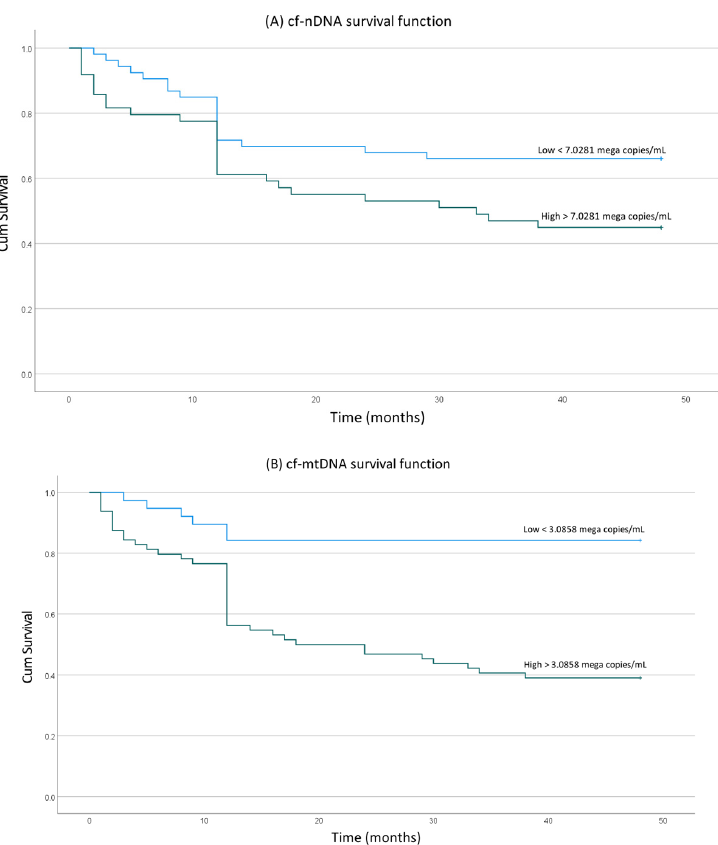
Figure 3. Kaplan–Meier estimates of the probability of overall survival of patients with HNSCC. Comparison between patients with higher and lower levels of ( A ) cf-nDNA and ( B )